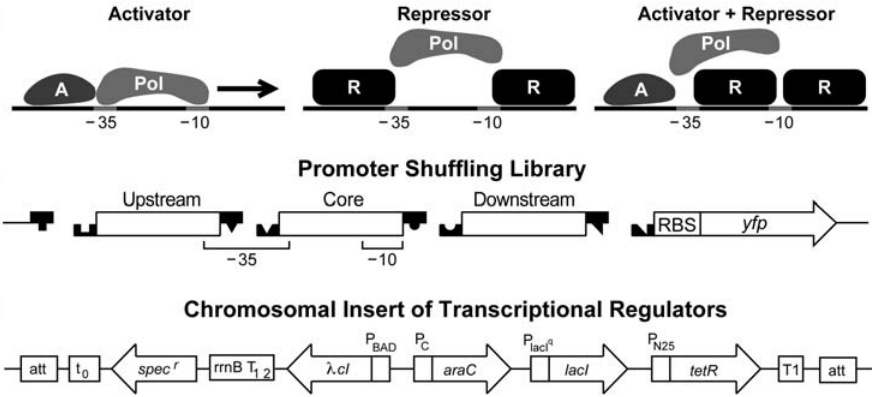
Figure 1. Description of synthetic promoter shuffling scheme. (A) Examples of promoters binding activator ‘A’ (left), repressor ‘R’ (middle) or both, activator and repressor (right). ‘Pol’ labels the RNAP. Activators nearly universally bind upstream of the 2 35 region in order to make direct, non- interfering contact with RNAP to help it bind. Repressors, on the other hand, can bind anywhere in the immediate region to successfully block RNAP binding. (B) Promoter shuffling scheme. We dissected the bacterial promoter into three regions encoding operator binding sequences (Upstream, Core, Downstream). The 2 35 and 2 10 RNAP binding sites and ribosomal binding site (‘RBS’) are indicated. The library consists of double-stranded DNA fragments with region-specific three-nucleotide overhangs allowing for ordered ligation to each other and, collectively, to a backbone vector. The complex promoter controls expression of a yfp gene. (C) Chromosomal insert of transcriptional regulators. araC , lacI , and tetR are transcribed from constitutive promoters, while l cI is regulated by an arabinose inducible promoter P BAD . Also indicated are the transcriptional terminators t 0 , rrnB T 1 2 , and T1; the gene for spectinomycin resistance spec r ; and the l phage attachment site, attB .